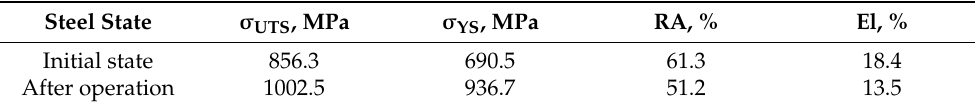
Table 2. Tensile mechanical properties of 34Kh3M steel for a steam turbine rotor disk. Steel State σ UTS ,